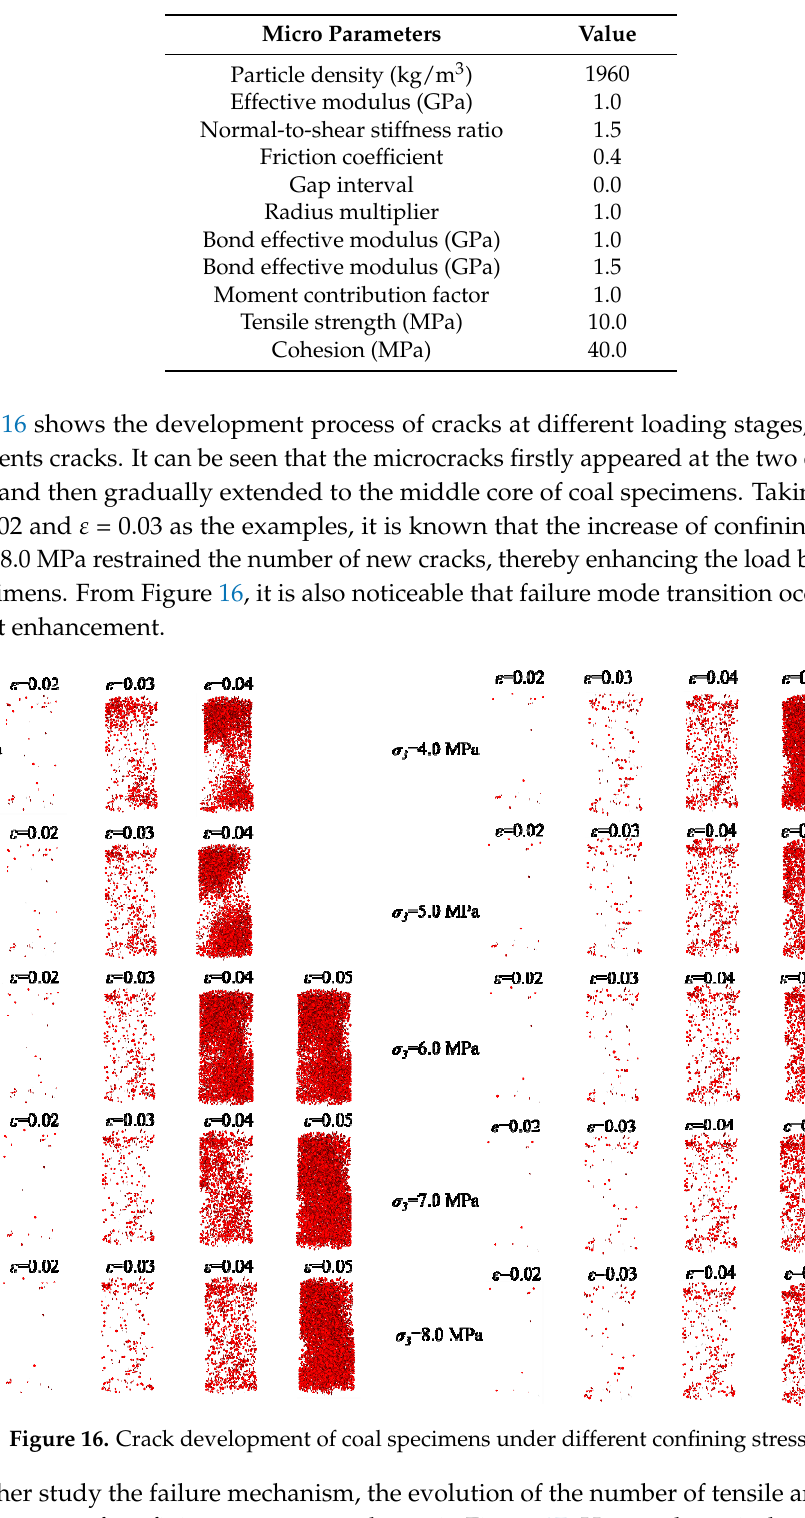
Table 2. Micro parameters of the parallel bond model.